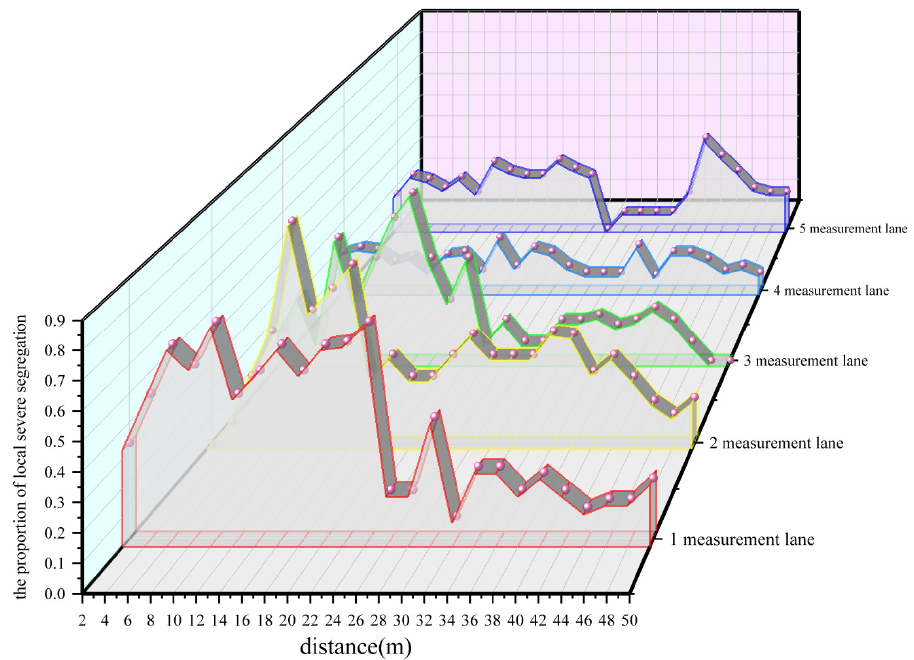
Figure 12. Proportion of local severe segregation on asphalt pavement.